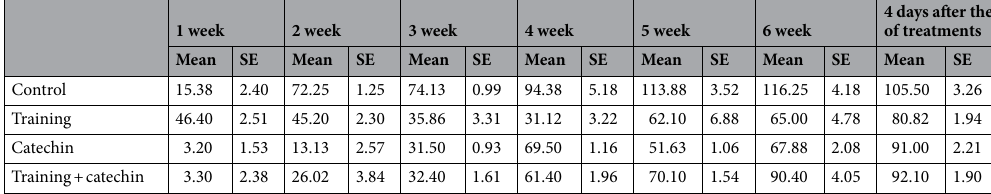
Table 5. DBP mean changes (mmHg) from basal values at the different times considered.